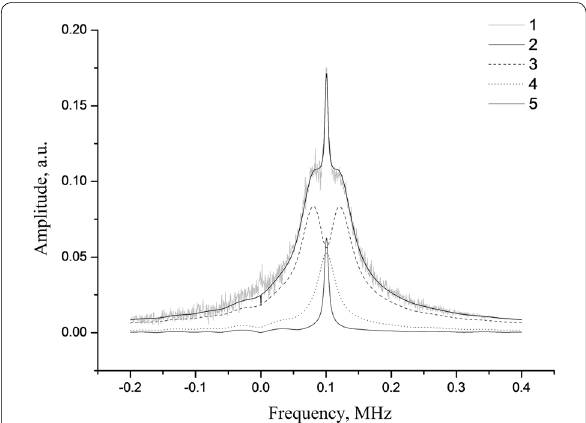
Fig. 3 Fourier transform spectrum of FID signal from protons of air-dry cotton cellulose: (1) original experimental spectrum, (2) simulated spectral line, (3) broad component, (4) medium component, and (5) narrow